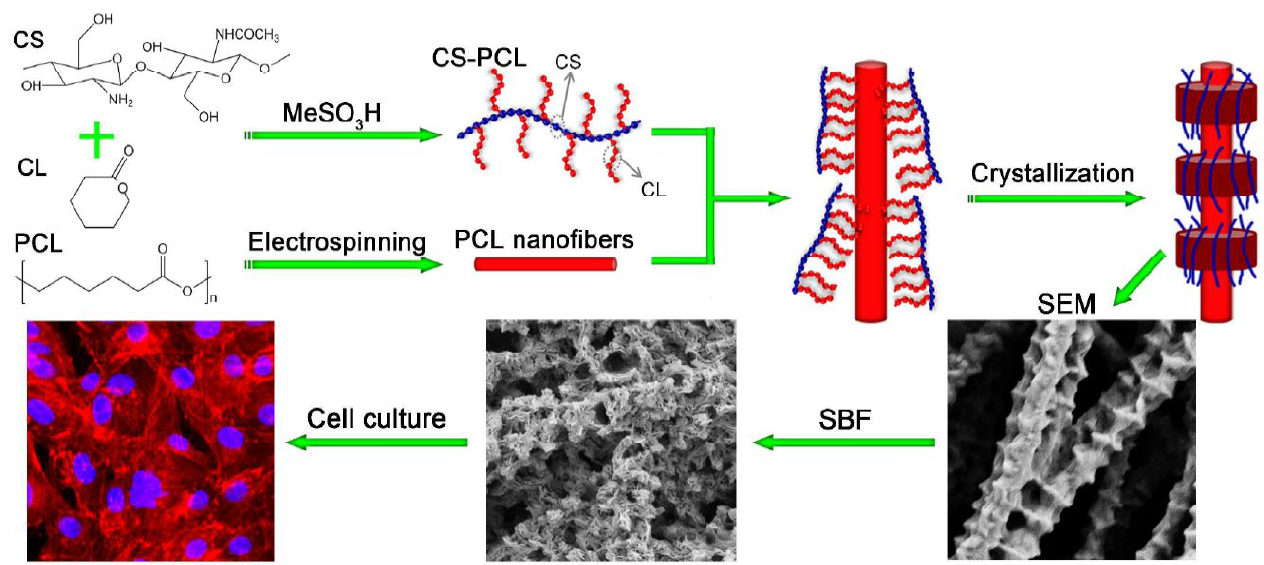
Figure 5. Preparation of chitosan-PCL biocomposite scaffolds displaying “shish kebab-like” morphology [120].